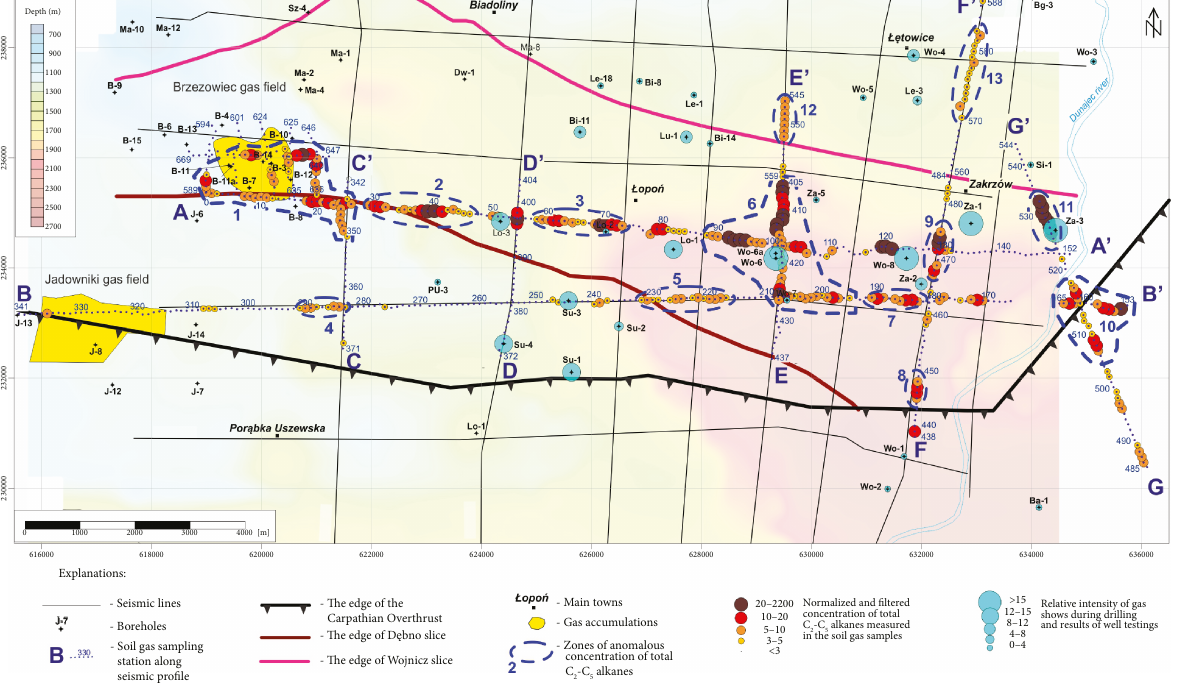
-C superimposed on a structural map of the Miocene 2 5